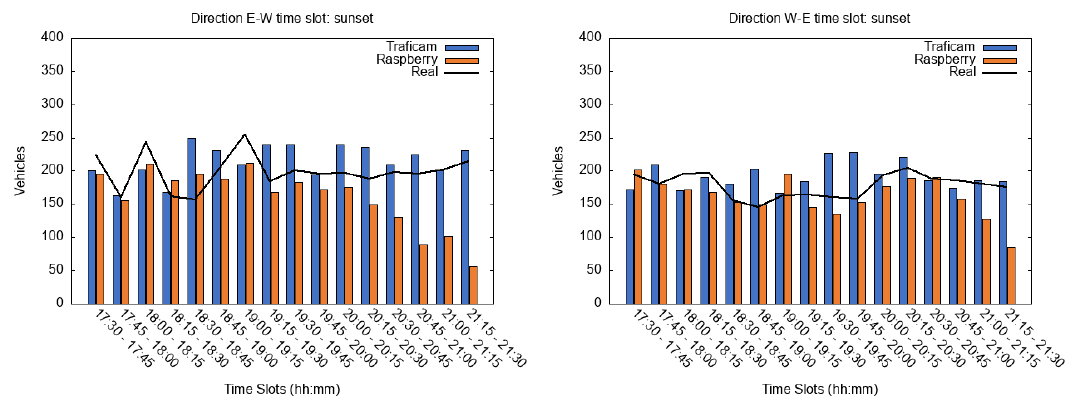
Figure 10. Comparison of Traficam (in blue) and Edge device (in orange) for vehicle counting during the sunset time slot. On left part of the figure, the direction E-W is shown, on the right part the direction is W-E.